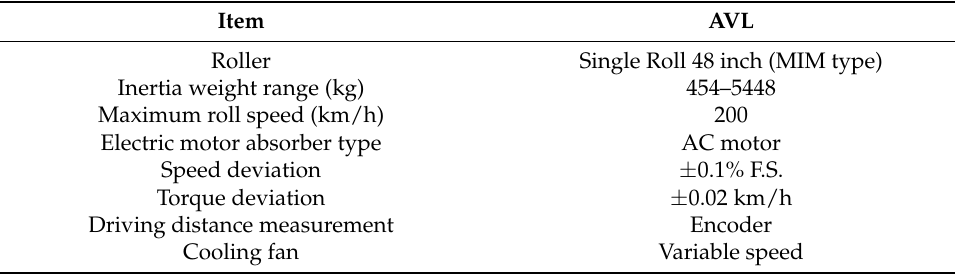
Figure 2. Schematic diagram of correlation test between the PEMS and laboratory exhaust emission analyzer. Table 1. Specifications of chassis dynamometer.